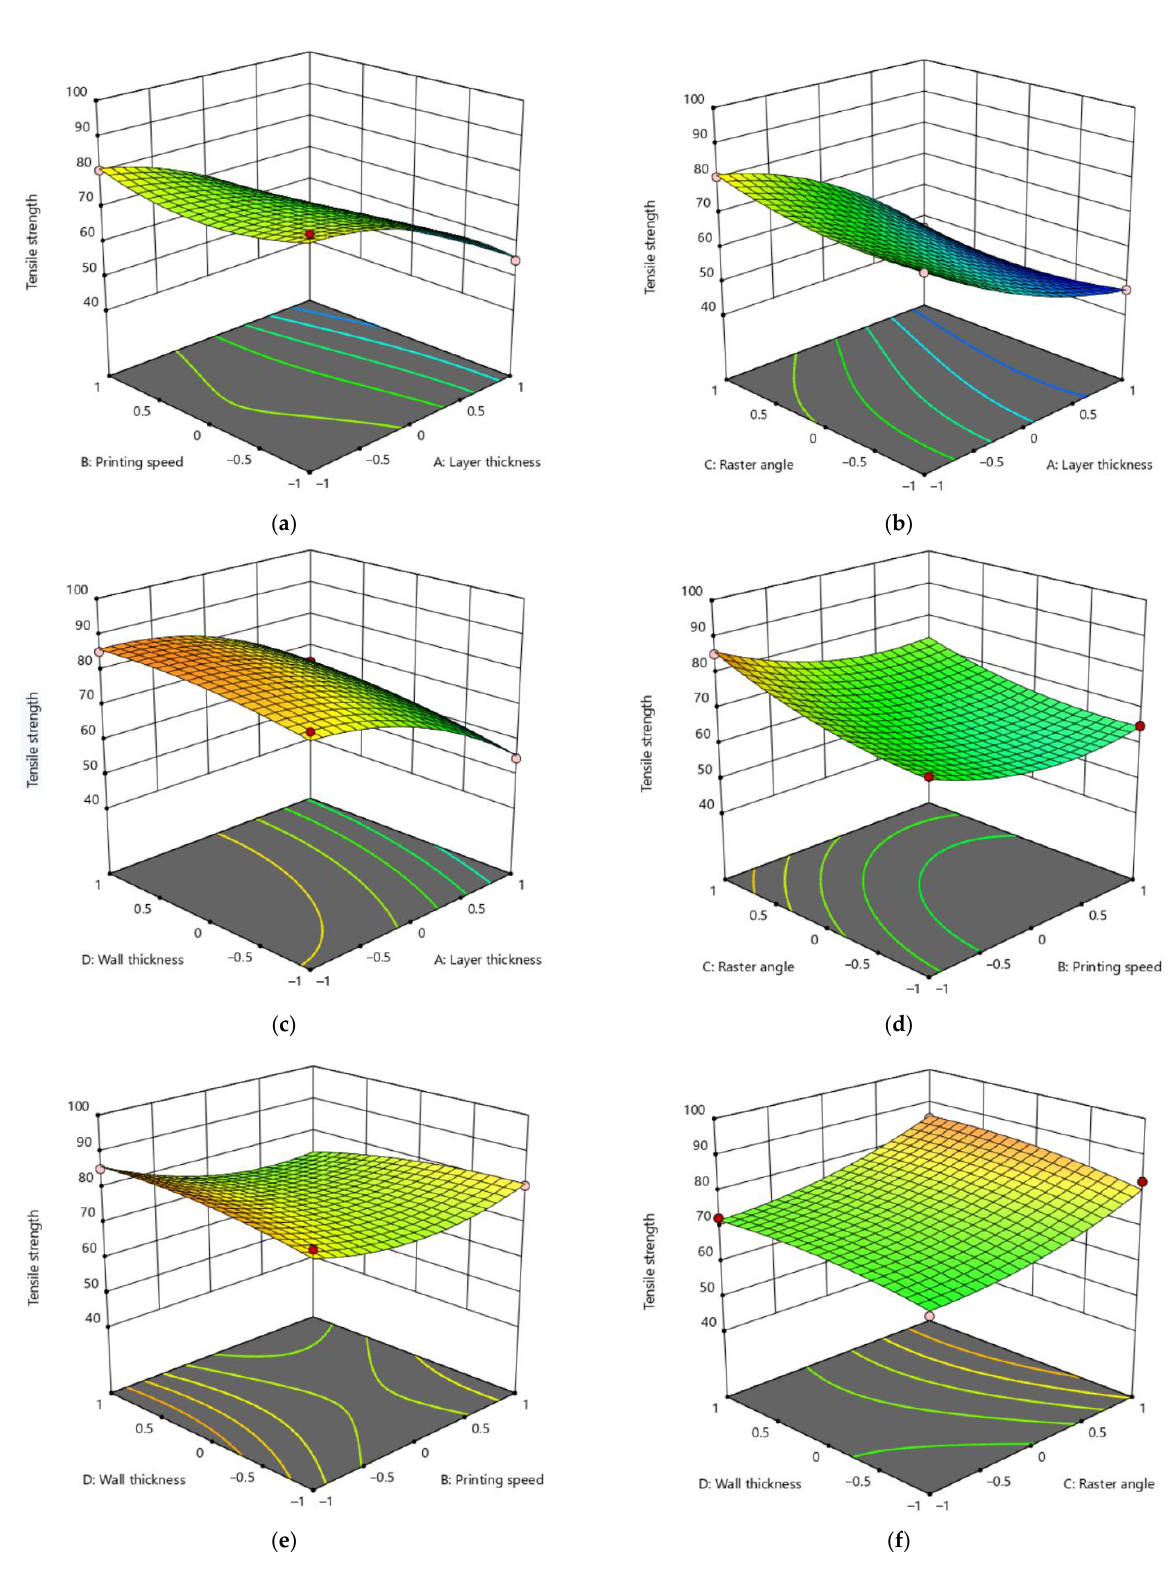
Figure 4. The 3D response surface plot: ( a ) printing speed vs. layer thickness; ( b ) raster angle vs. layer thickness; ( c ) wall thickness vs. layer thickness; ( d ) raster angle vs. printing speed; ( e ) wall thickness vs. printing speed; ( f ) wall thickness vs. raster angle.